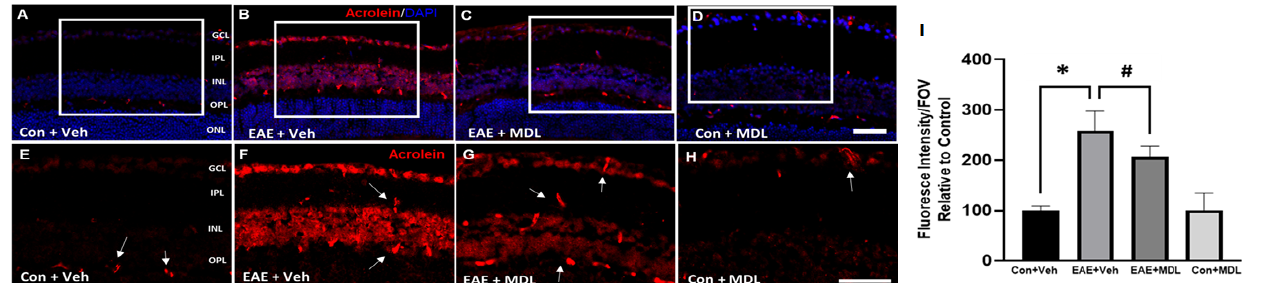
Figure 8. Conjugated acrolein level is downregulated in response to MDL 72527 treatment. ( A – D ) Representative immunostaining images of retinal cryostat sections using conjugated acrolein antibody show elevated levels of conjugated acrolein in the vehicle-treated EAE retinas (30 days post-induction) compared to control. MDL 72527 treatment markedly reduced EAE-induced acrolein formation. Arrows represent areas of nonspecific staining. Scale bar 50 µ m. ( E – H ) Magnified images of the boxed regions demonstrating the changes in acrolein levels. ( I ) Quantification of fluorescent intensity. Data are presented as mean ± SD. * ( p < 0.01); # ( p < 0.05). GCL, ganglion cell layer; INL, inner nuclear layer; IPL, inner plexiform layer; ONL, outer nuclear layer; OPL, outer plexiform layer. N = 5–6 per group and representative images are presented.